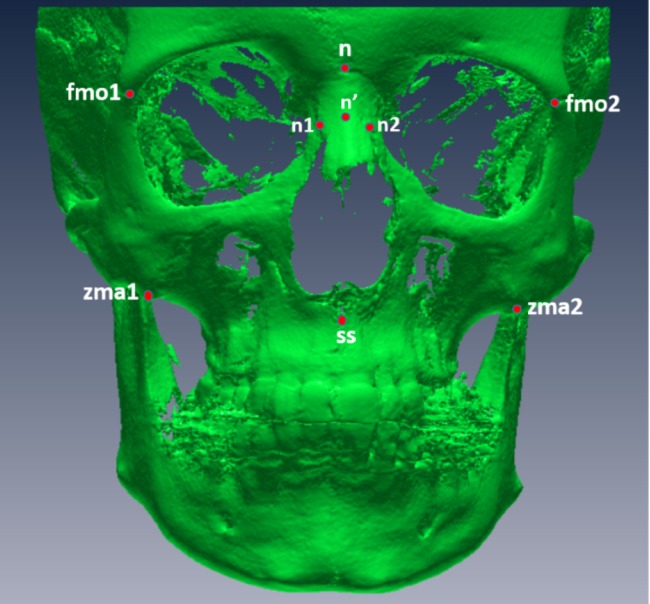
Digitized points from a frontal view.fmo1, right frontomalare orbitale; fmo2, left frontomalare orbitale; n, nasion; n′, nearest point of the median ridge of the nasal bone; n1, right deepest point on the lateral wall of nasal bone; n2, left deepest point on the lateral wall of the nasal bone; zma1, right zygomaxillary anterius; zma2, left zygomaxillary anterius.